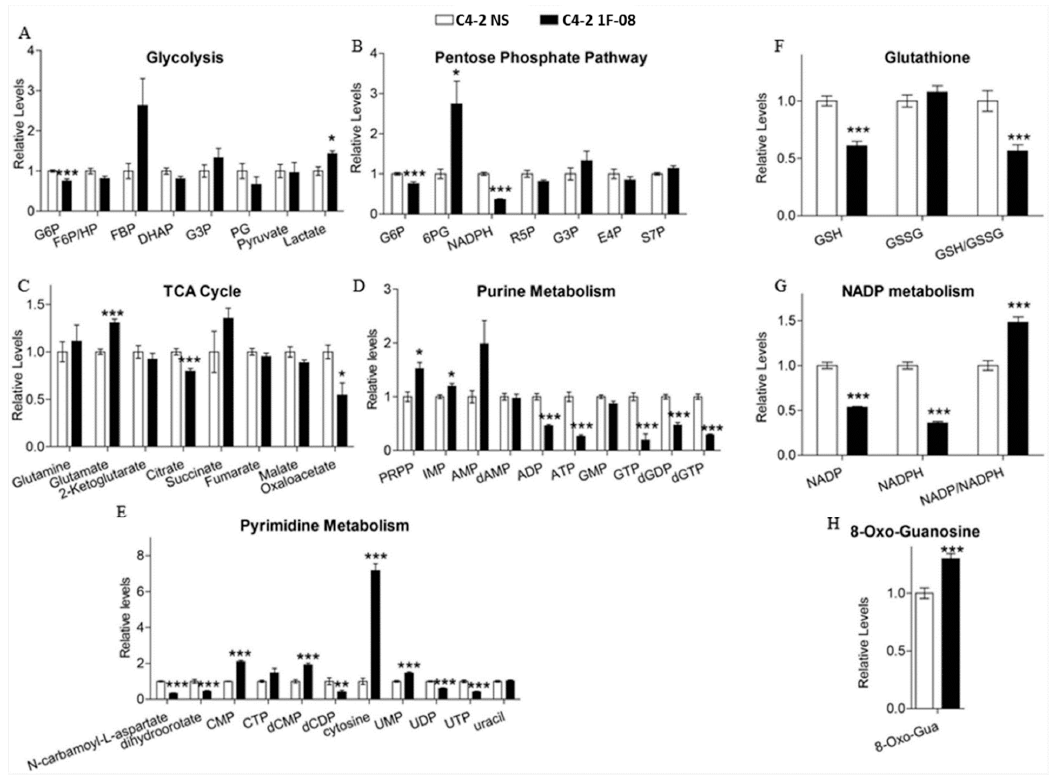
Figure 5. PXDN facilitates metabolic alterations. Metabolomics was performed on C4-2 NS (control) and C4-2 1F-08 (PXDN knockdown) cells. Metabolites examined included those involved in ( A